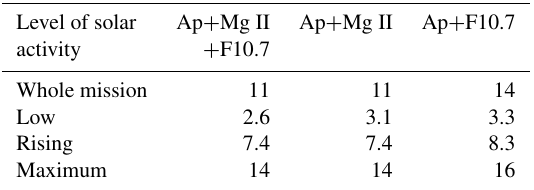
Table 2. Comparison of normalized RMSE values (in %) for differ- ent optimal combinations of